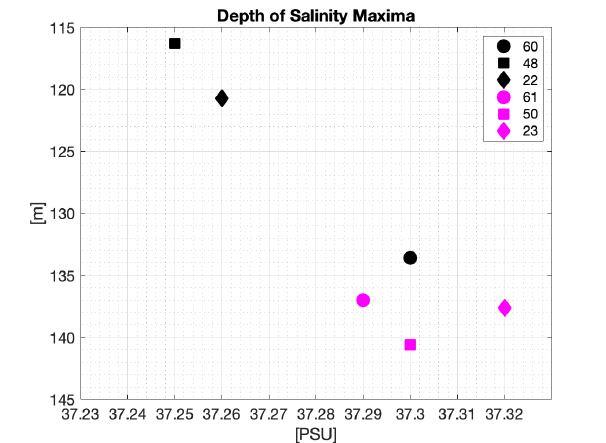
Figure 3. Depth of Salinity maxima for Stations 60, 48, and 22 (shallow), and 61, 50, 23 (deep).